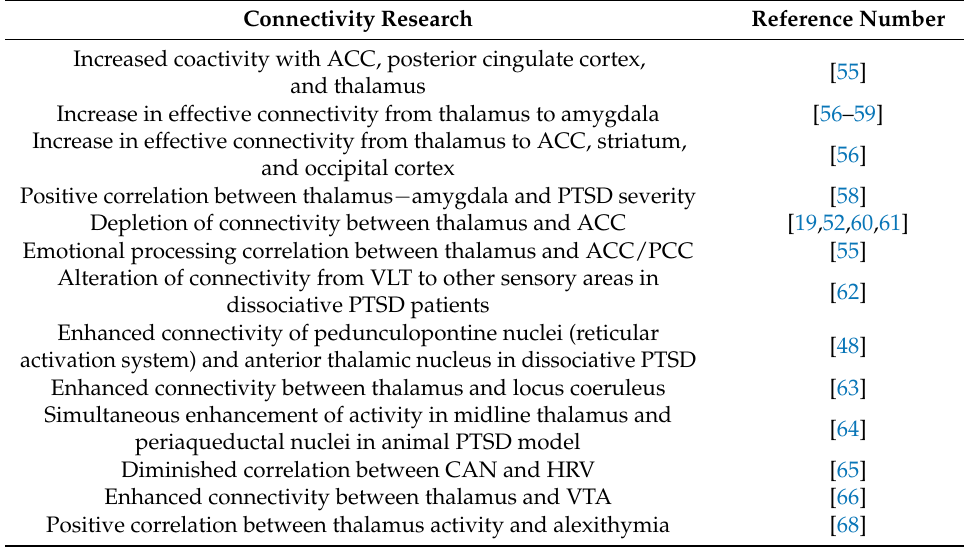
Table 2. The summary of literature study for connectivity in the thalamus.